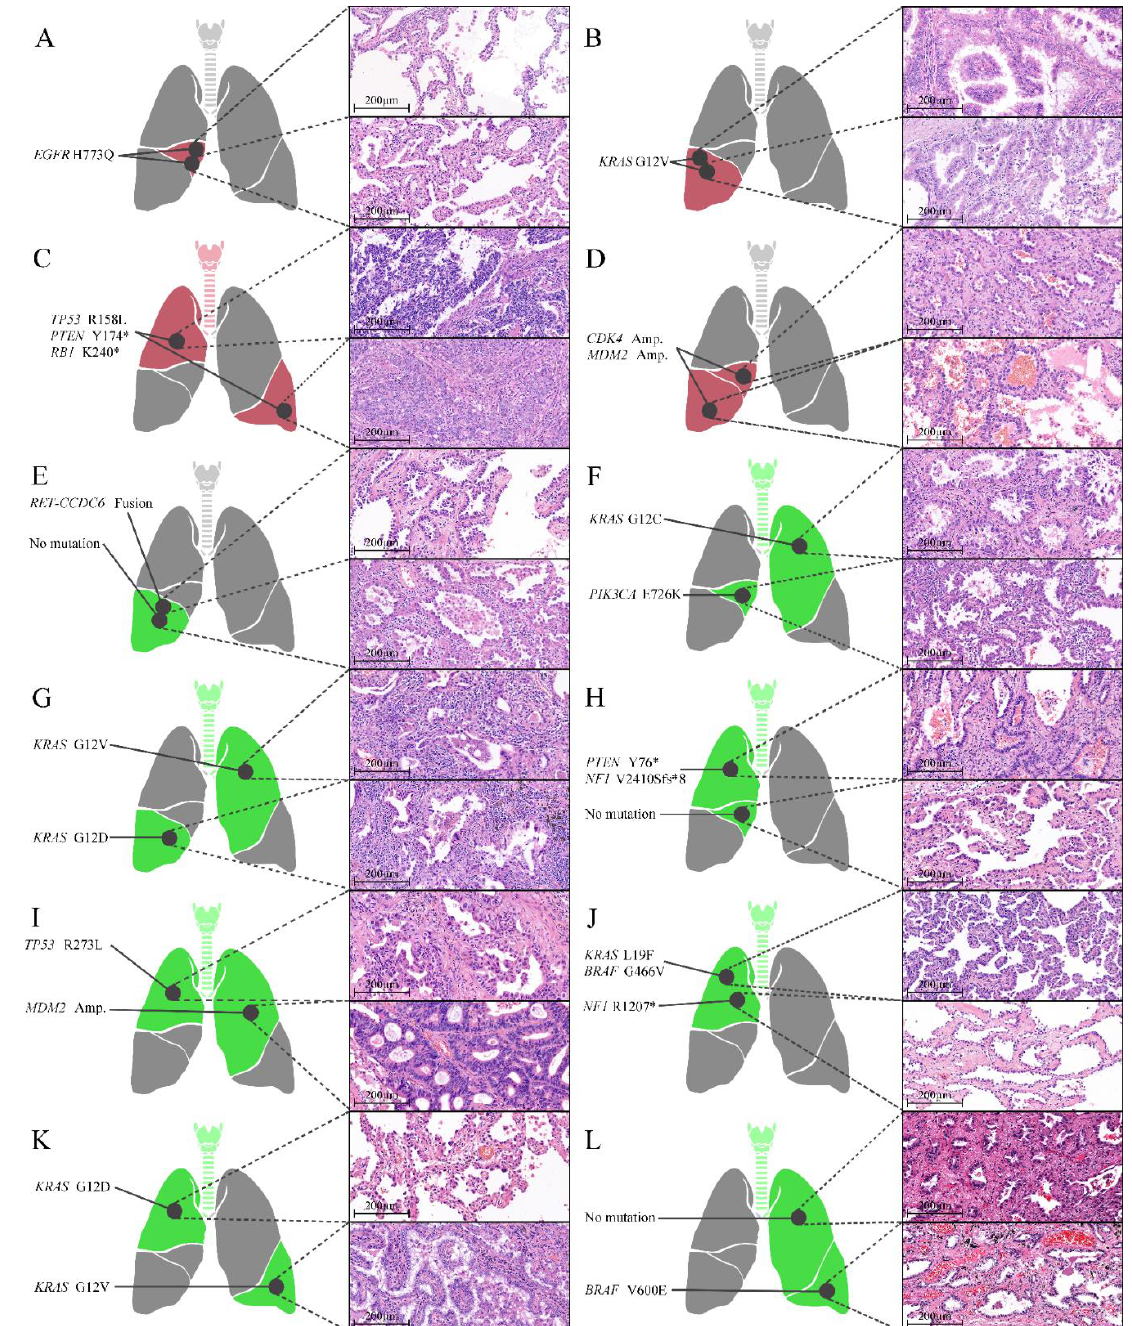
Figure 2. Locations, histological characteristics ( H&E- stained sections), and molecular alterations of individual tumors of 12 pairs of EGFR -wildtype tumors. Four tumors ( A – D ) shared the same molecular alterations (red), while eight tumors ( E – L ) exhibited different molecular alterations (green). * stop-gain mutation